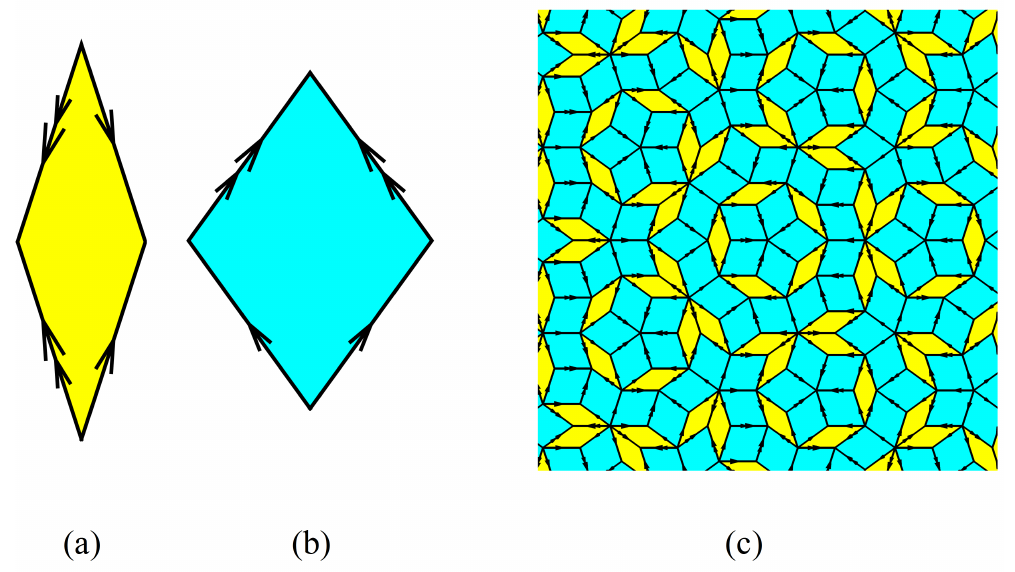
Figure 2. ( a ) The narrow prototile (vertex angles π /4 and 4 π /5) and ( b ) the wide prototile (vertex angles 2 π /5 and 3 π /5) of the Penrose tiling; ( c ) the tiling obtained based on specific matching rules, which requires aligning arrows and double arrows, while placing prototiles next to each